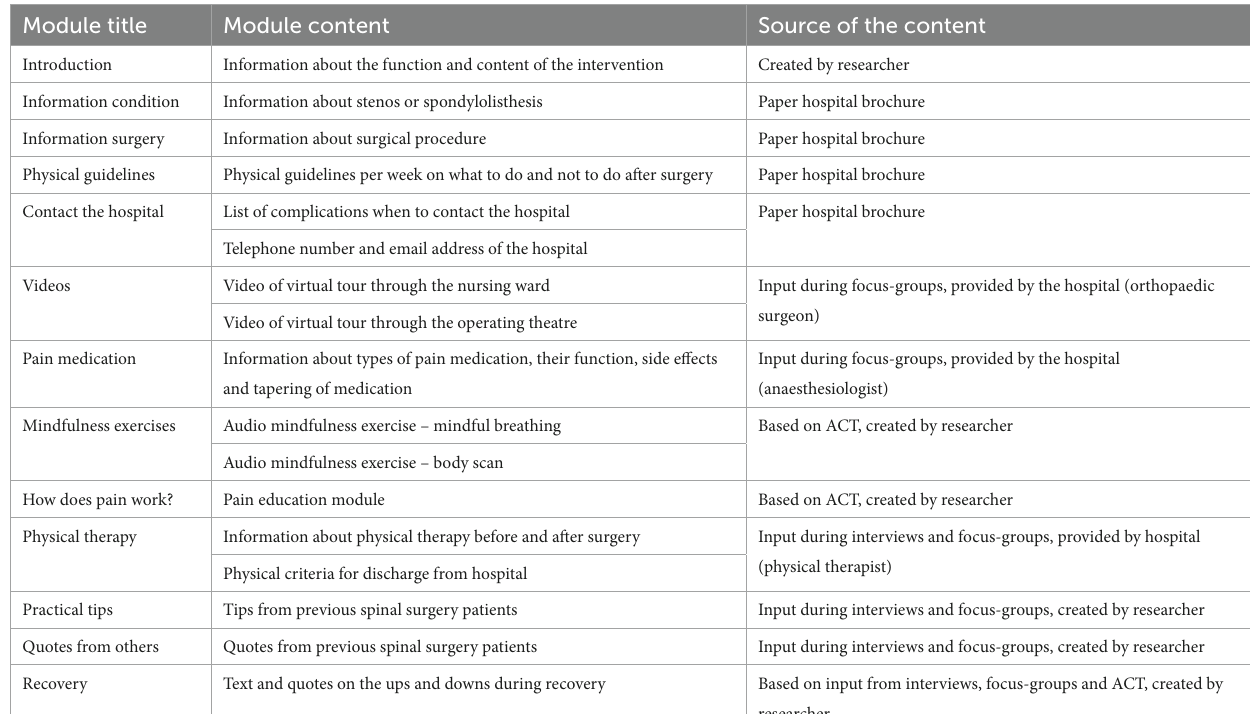
TABLE 2 Content of the intervention Strength